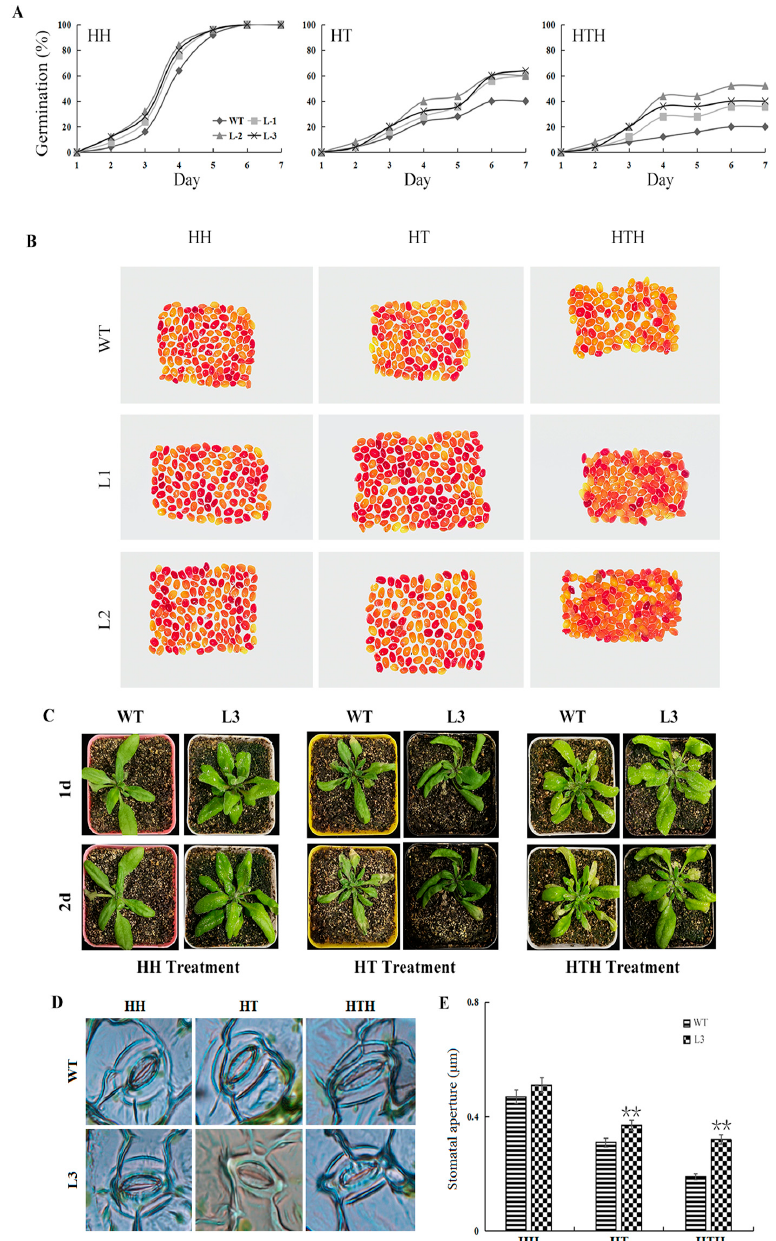
Figure 4. Phenotype, seed germination, and viability of WT and GmATX1 -overexpressed Arabidopsis lines under HT, HH, and HTH treatments. ( A ) Germination percentages of seeds harvested from the WT and GmATX1 -overexpressed Arabidopsis lines (L1, L2 and L3) after the HT (40/20 °C, 12 h/12 h (light/dark) and 70% RH), HH (23/20 °C, 12 h/12 h (light/dark) and 100% RH), and HTH (40/20 °C, 12 h/12 h (light/dark) and 100% RH) treatments, respectively. ( B ) Viability of the seeds harvested from the WT and transgenic Arabidopsis lines (L1 and L2) after the HT, HH, and HTH treatments, respectively. Dark red staining indicates viable seeds. ( C ) Illustration of the 4-week-old WT and transgenic Arabidopsis line (L3) after the HT, HH, and HTH treatments, respectively, for 2 d. ( D , E ) Stomatal morphology and stomatal aperture of the 4-week-old WT and transgenic Arabidopsis lines (L3) under the HH, HTH, and HT stresses, respectively. Values are mean ± SD from three biological replicates. ** indicates significant differences between the WT and transgenic Arabidopsis lines (L3) at p <